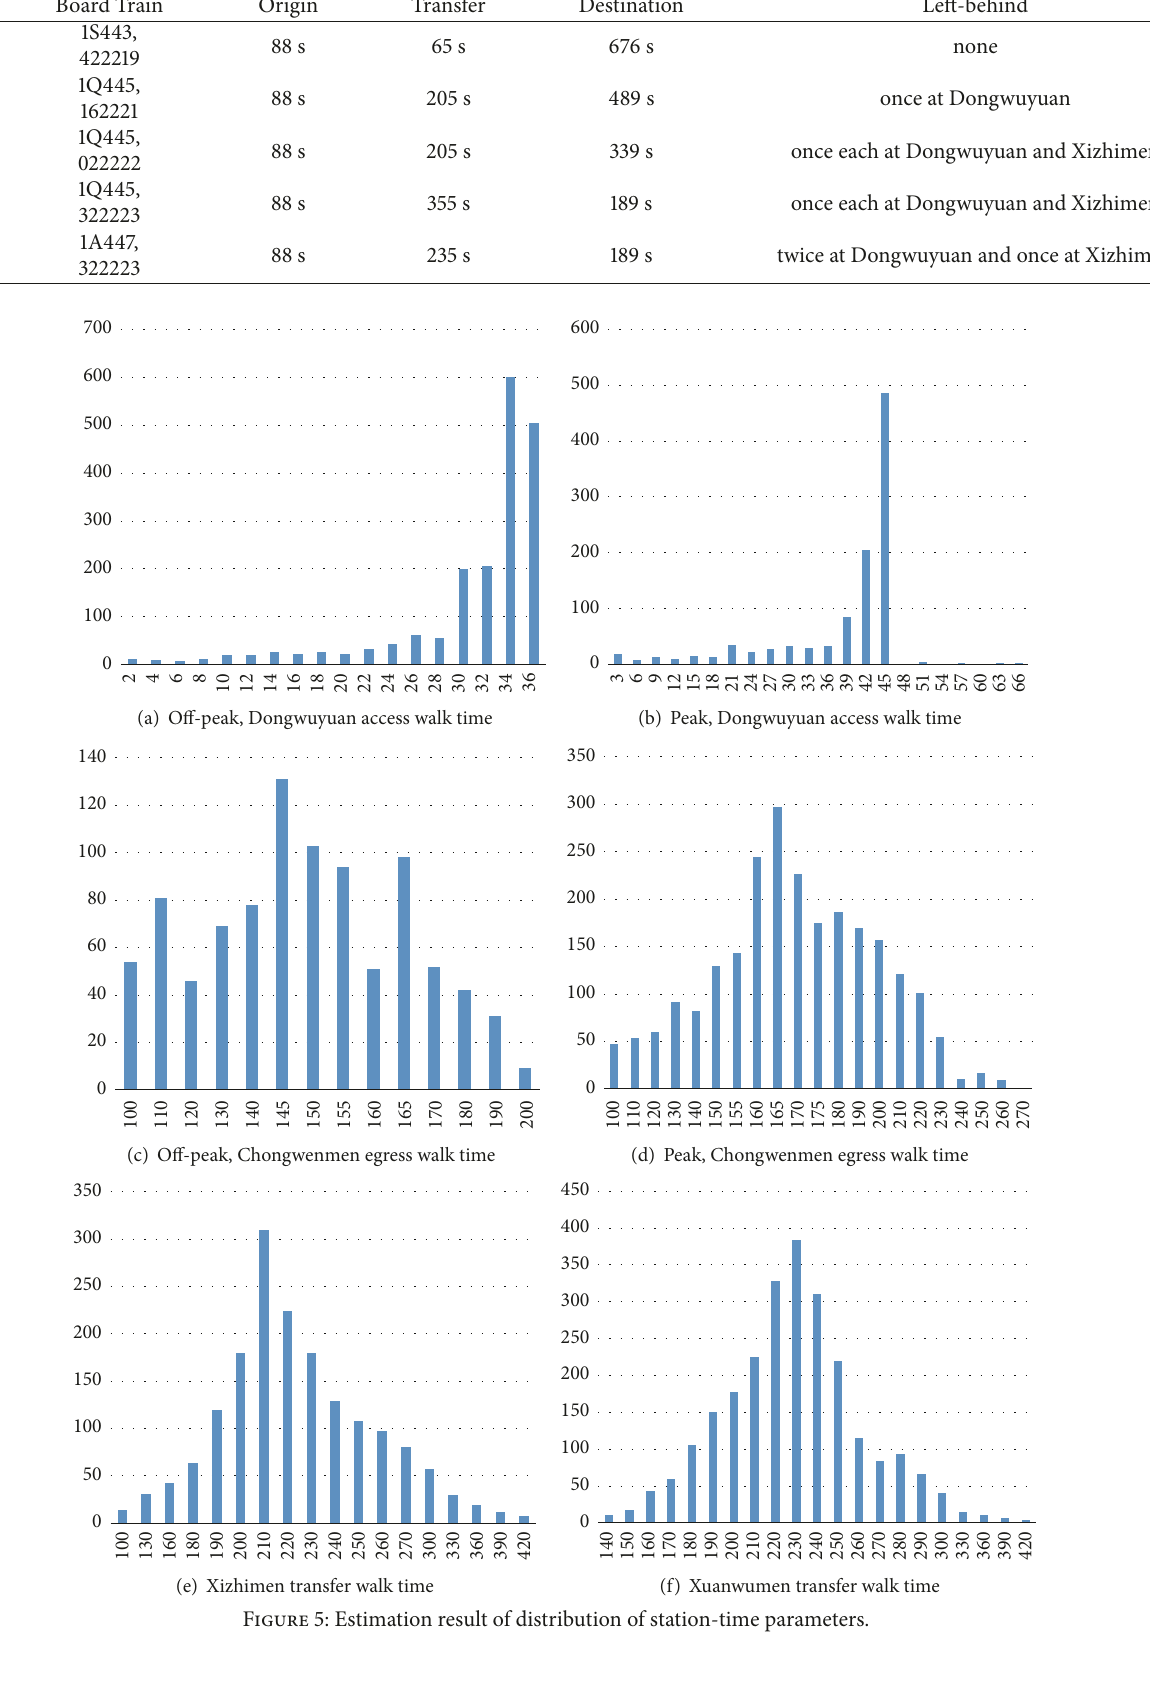
Table 7: Detailed information of theoretical feasible space-time-sequence trajectories.